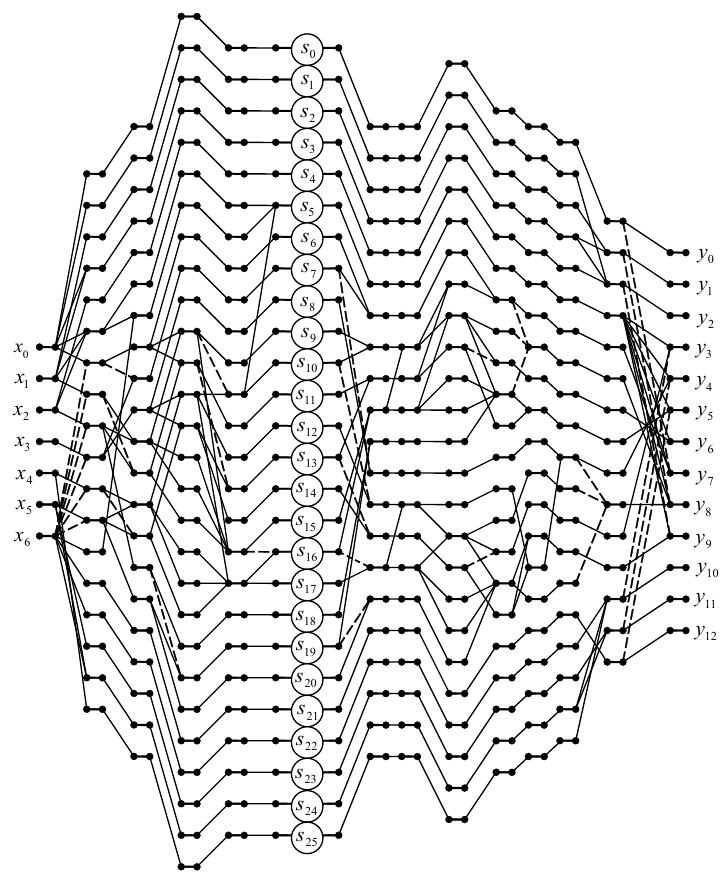
Figure 6. The signal flow graph of the proposed algorithm for computation of 7-point linear